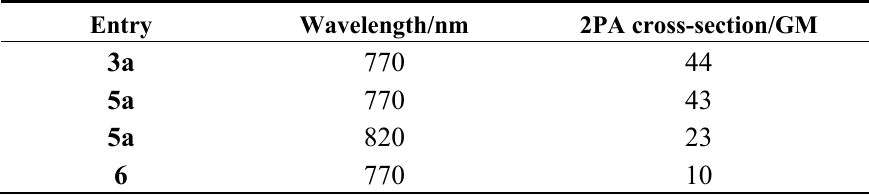
Table 2. Two-photon absorption (2PA) cross-section values of 3a , 5a , and 6